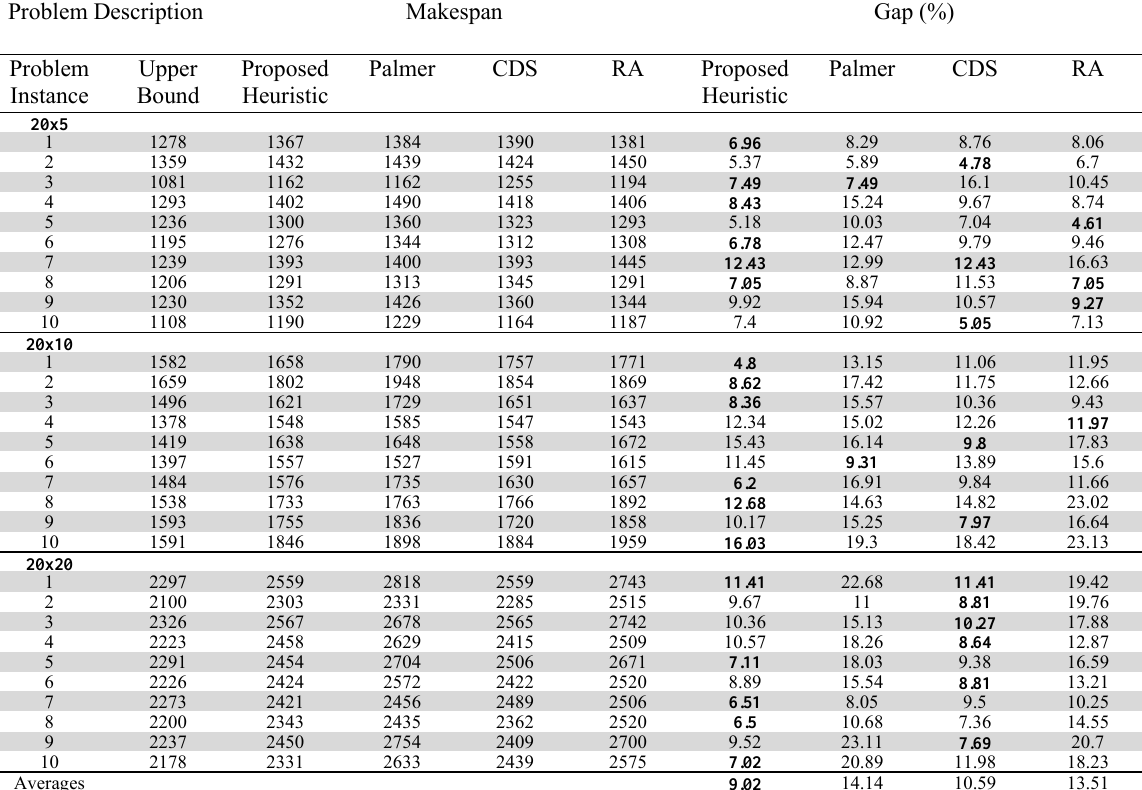
Makespans and percentage gaps for Taillard’s 20-Job benchmark problems Problem